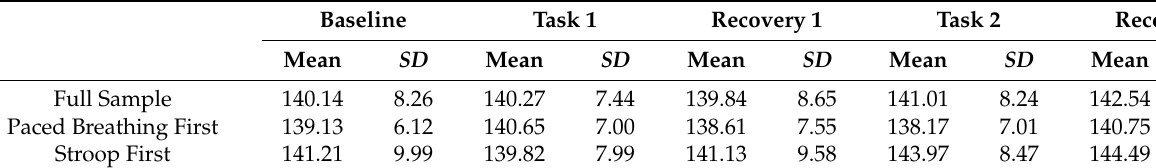
Table 2. Fetal Heart Rate Values Across All Experimental Periods.